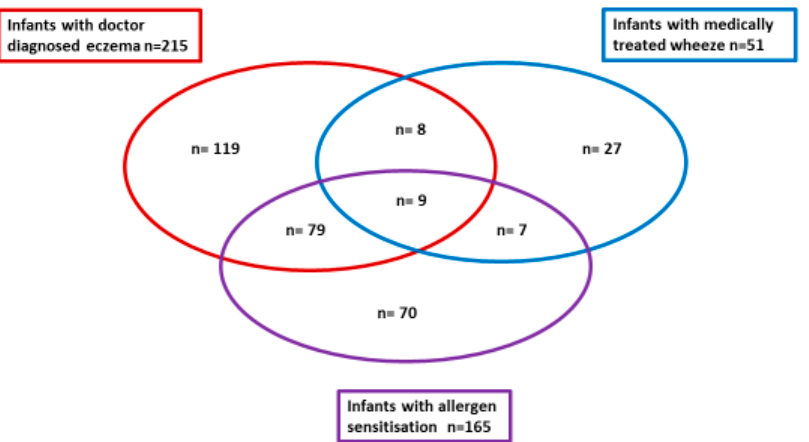
Figure 1. Infant clinical phenotype clusters of doctor diagnosed eczema, medically treated wheeze, and allergen sensitization outcomes during infancy. There were only 17 infants in total with both doctor diagnosed eczema and medically treated wheeze clinical phenotypes.